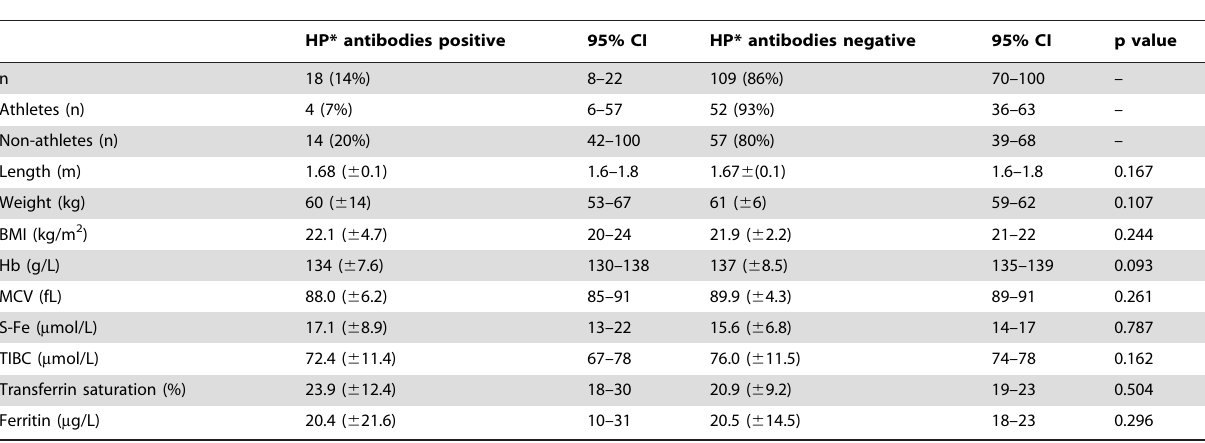
Table 1. Major laboratory findings in HP positive and negative subjects.